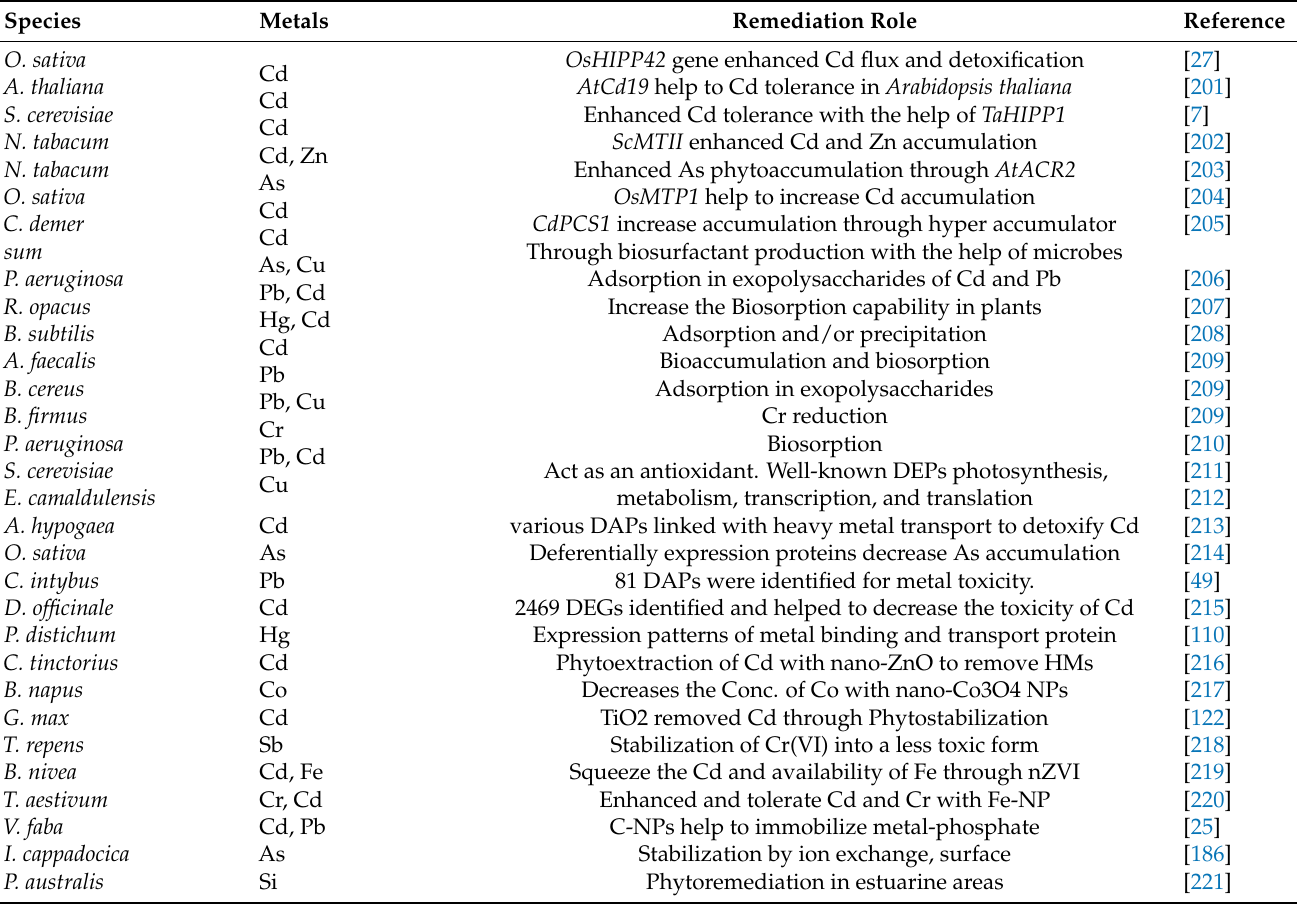
Table 2. Biotechnology approaches and metal detoxifying mechanism of HMs by invasive and other naturalized plant